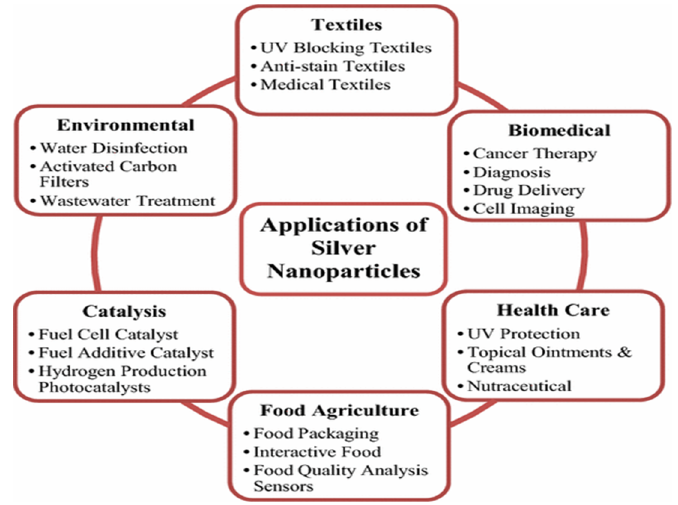
Figure 1. Applications of AgNPs. Reproduced from [22], Springer Open.